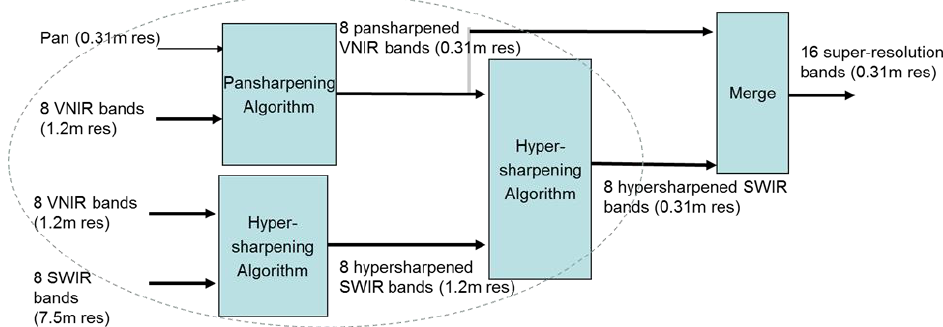
Figure 7. Approach 4: A parallel pansharpening step first, followed by a sequential fusion step for enhancing WV-3 images.